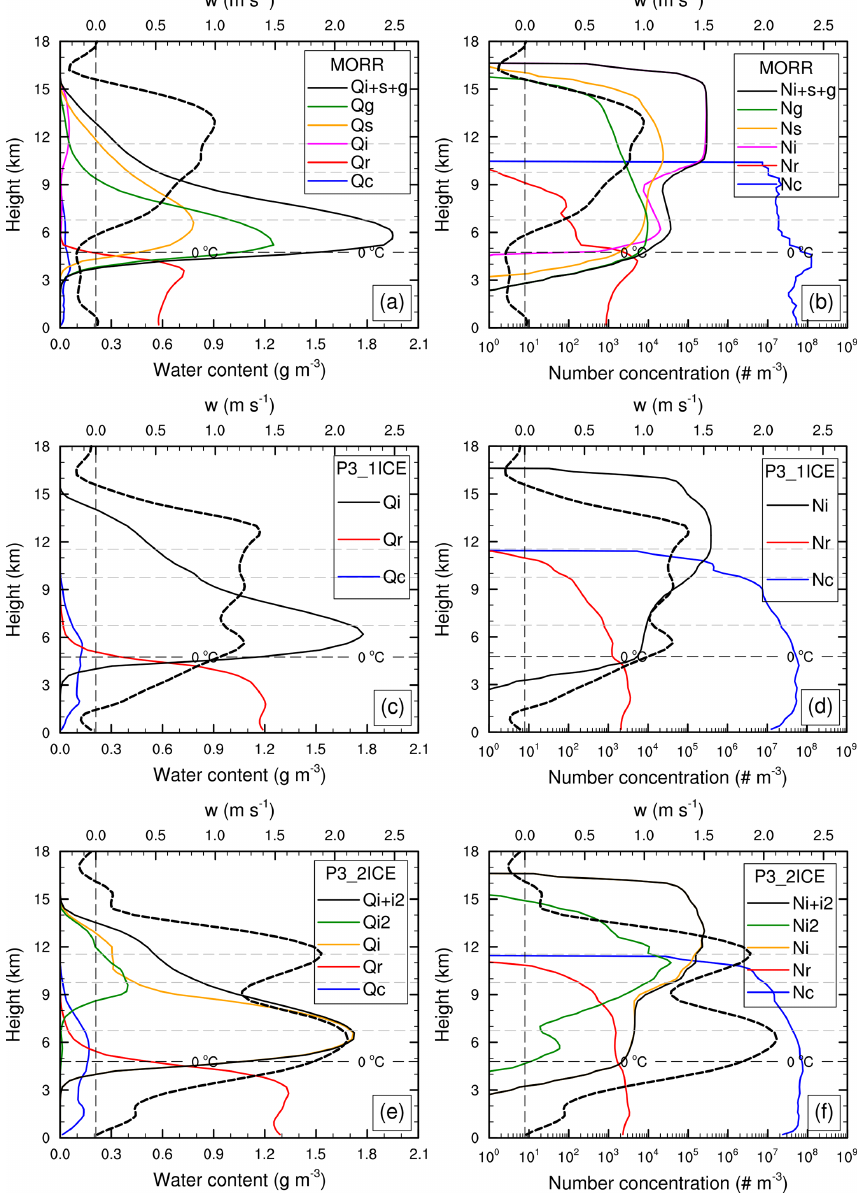
Figure 12. Vertical profiles of averaged water content ( a, c, e , solid curves, gm − 3 ) and total number concentration ( b, d, f , solid curves, #m − 3 ) of each hydrometeor category in MORR ( a, b – cloud water: blue; rain water: red; cloud ice: magenta; snow: orange; graupel: green; and sum of ice species: black), P3-1ICE ( c, d – cloud water: blue; rain water: red; and cloud ice of first category: black), and P3-2ICE ( e, f – cloud water: blue; rain water: red; cloud ice of first category: orange; cloud ice of second category: green; and sum of two ice categories: black). The thick black dashed lines represent vertical profiles of vertical velocity (ms − 1 ). The vertical thin black dashed lines indicate vertical velocity of 0ms − 1 . The horizontal thin black and gray dashed lines indicate the heights of temperatures at 0, − 10, − 30, and − 45 ◦ C from bottom to top, respectively. The numbers of samples used to calculate the averages are shown in Table 2.